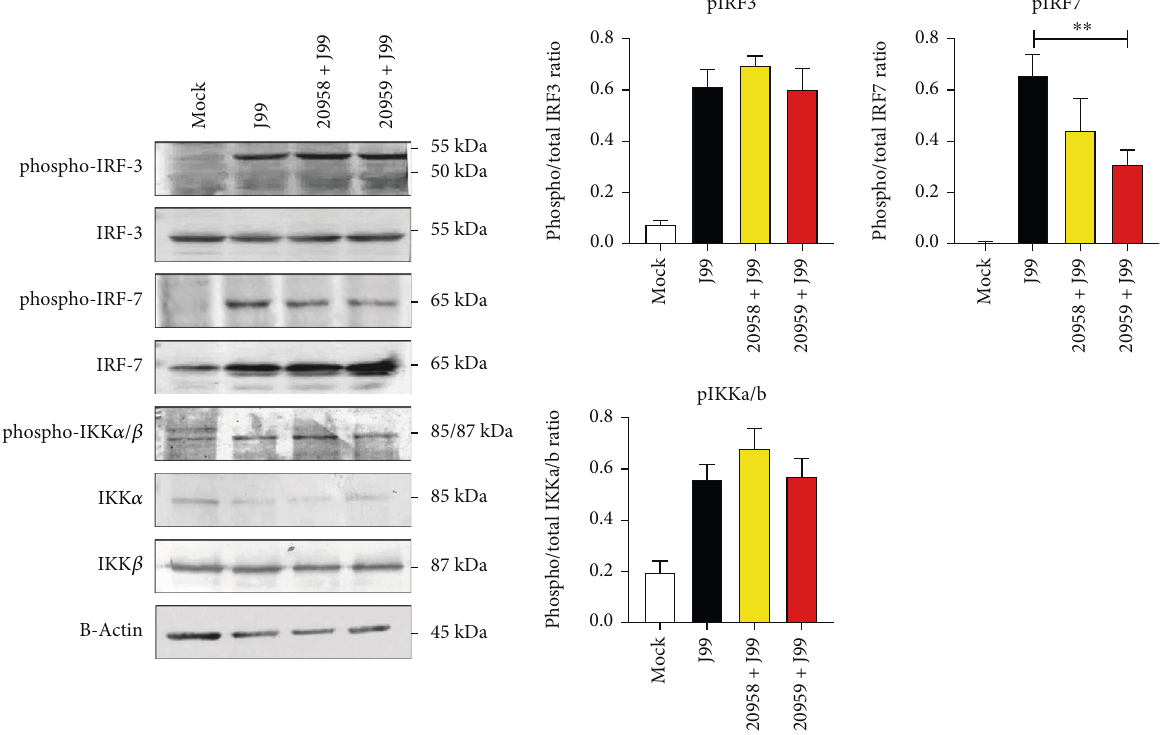
Figure 8: Immunoblot analysis of TLR downstream signaling pathway molecules. THP-1 cells were infected with H. pylori J99 strain at MOI 10 for 16 hours. Cells were lysed and processed for immunoblot analysis with antibodies to phospho- or total IRF-3, IRF-7, IKK α / β , and β - actin as loading control. (a) Western blot data. (b) Bar charts showing average ratio of phosphorylated over total protein after normalizing to the β -actin level. Data is representative of two independent experiments. Statistical signi fi cance was analyzed using Student ’ s t -test ( ∗∗ P ≤ 0 : 01